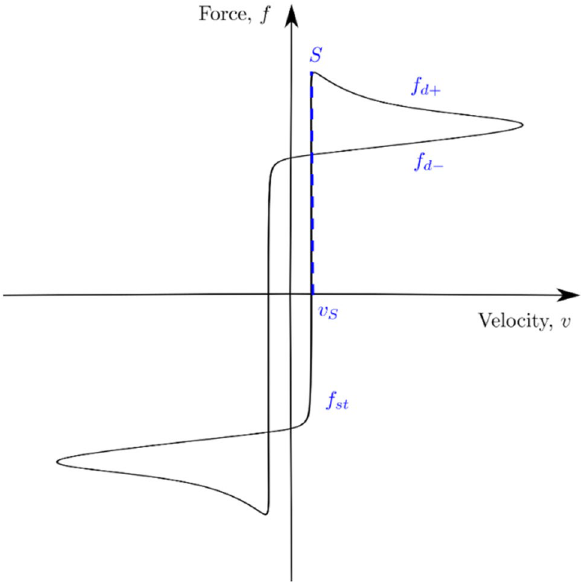
Figure 12. Typical load-velocity graph reproduced based on ref 26